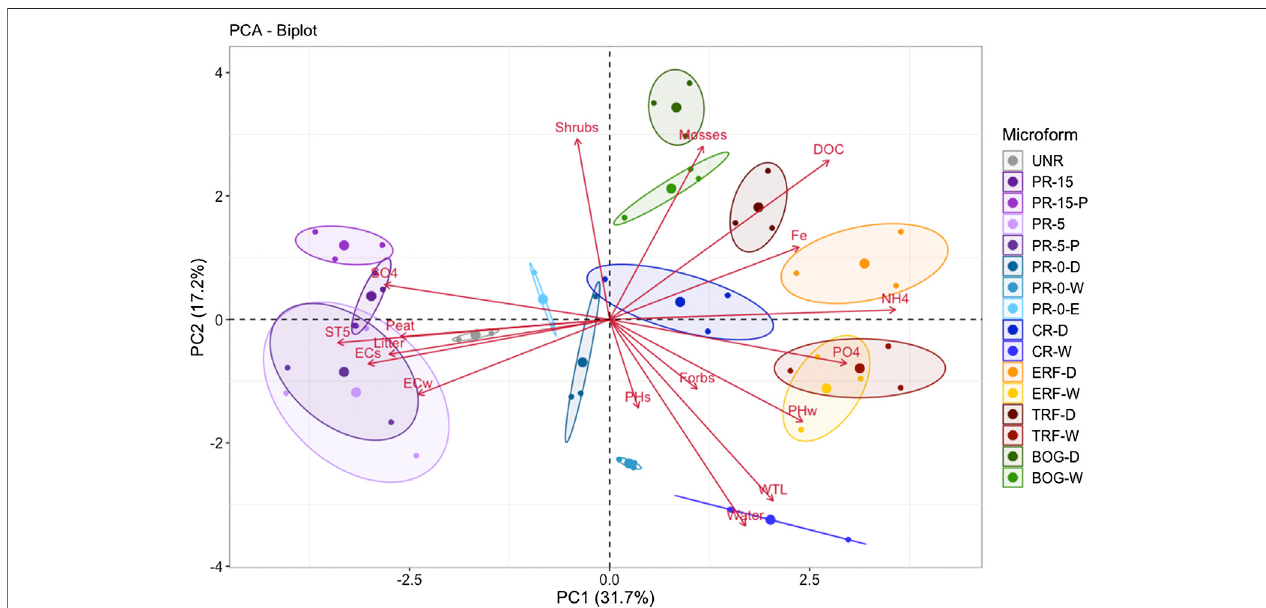
FIGURE5| Principlecomponentanalysis(PCA)ofmicroforms,accordingtoenvironmentalcontrolsofwatertablelevel(WTL),soiltemperatureat5 cmdepth(ST 5 ), soil pH (pH S ) and electric conductivity (EC S ), water pH (pH W ) and electric conductivity (EC W ), dissolved organic carbon (DOC), vegetation survey strata (shrubs, forbs, mosses, water, litter, peat), and plant available soil nutrient supply rates (Fe, NH 4 , PO 4 , SO 4 ). Strong clustering of monitoring sectors* can be observed.* Restored sectors: UNR (cid:2) unrestored, PR-15 (cid:2) partial removal of mineral soil (MS) to 15 cm above seasonal water table, PR-5 (cid:2) partial removal of MS to 4 – 6 cm above seasonal water table, PR-0-D/W (cid:2) partial removal of MS to surface elevation of surrounding fen reference ecosystem (uneven ground relief with microforms dry (D) and wet (W), PR-0-E (cid:2) partial removal of MS to near the surrounding fen reference ecosystem (even ground relief), CR (cid:2) complete removal of mineral soil (MS). Reference ecosystem (REF): SRF (cid:2) shrubby extreme-rich fen; TRF (cid:2) treed rich fen, BOG (cid:2) wooded bog.